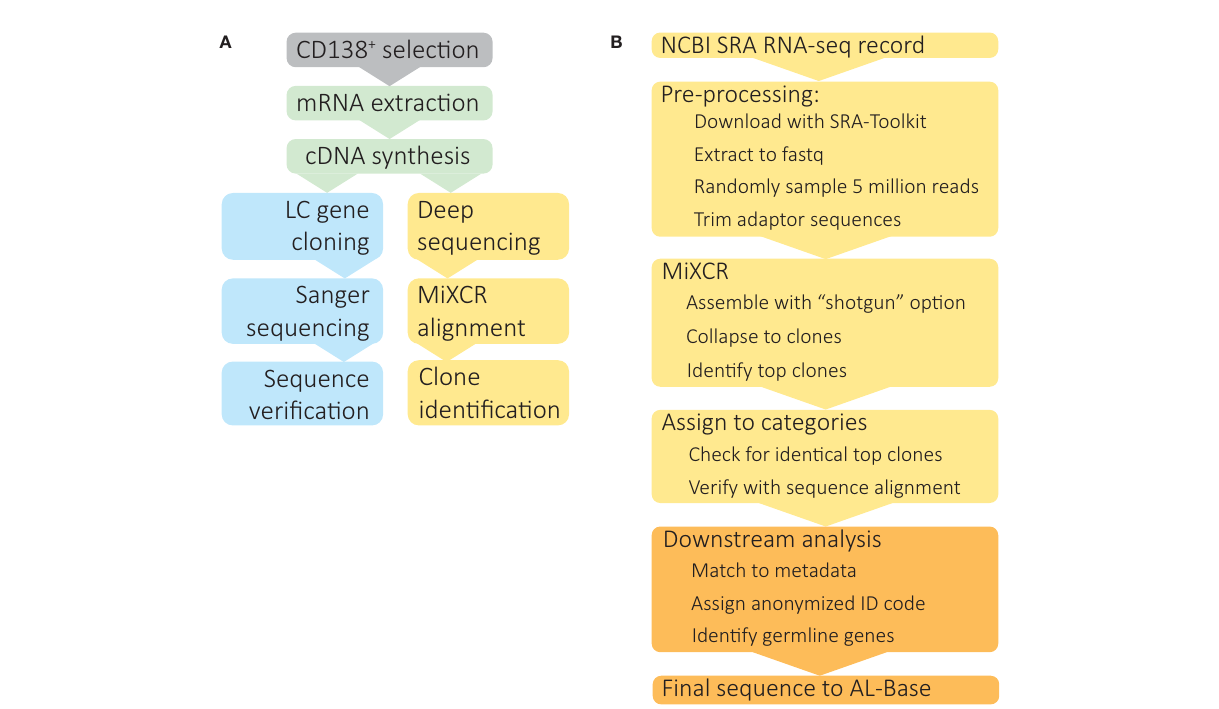
FIGURE 1 Identi fi cation of clonal IGV L -IGJ L sequences from untargeted RNAseq data. (A) Schematic depiction of IGV L -IGJ L sequence determination methods. Following optional enrichment of CD138+ plasma cells, total mRNA is extracted and cDNA synthesized by reverse transcription. Standard IGV L -IGJ